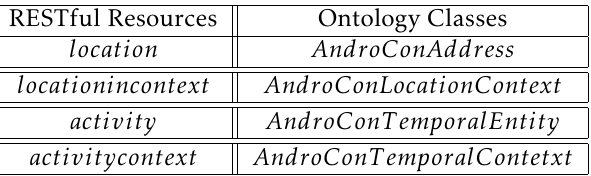
Table 2. MappingRESTfulResourcesto OntologyClasses RESTful